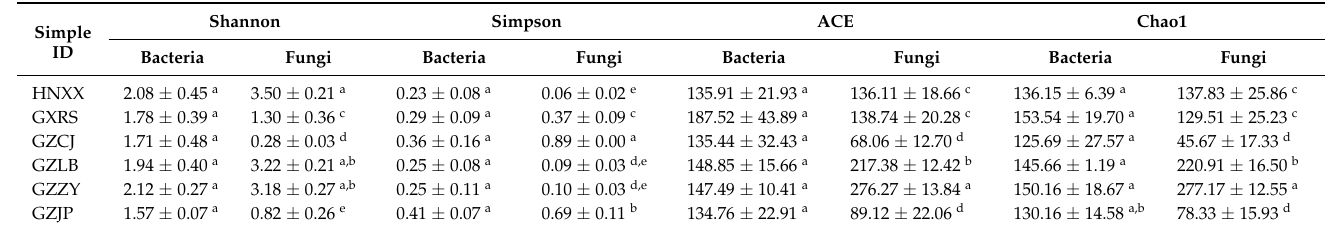
Figure 1. Variations in the microbial diversity and community structure of SR from different regions. ( A ) Rarefaction curves of bacteria and fungi for each sample. ( B ) Shannon index curves of bacteria and fungi for each sample. ( C , D ) PcoA score plots and NMDS of bacteria and fungi. Table 3. Richness and diversity of bacteria and fungi of SR from different